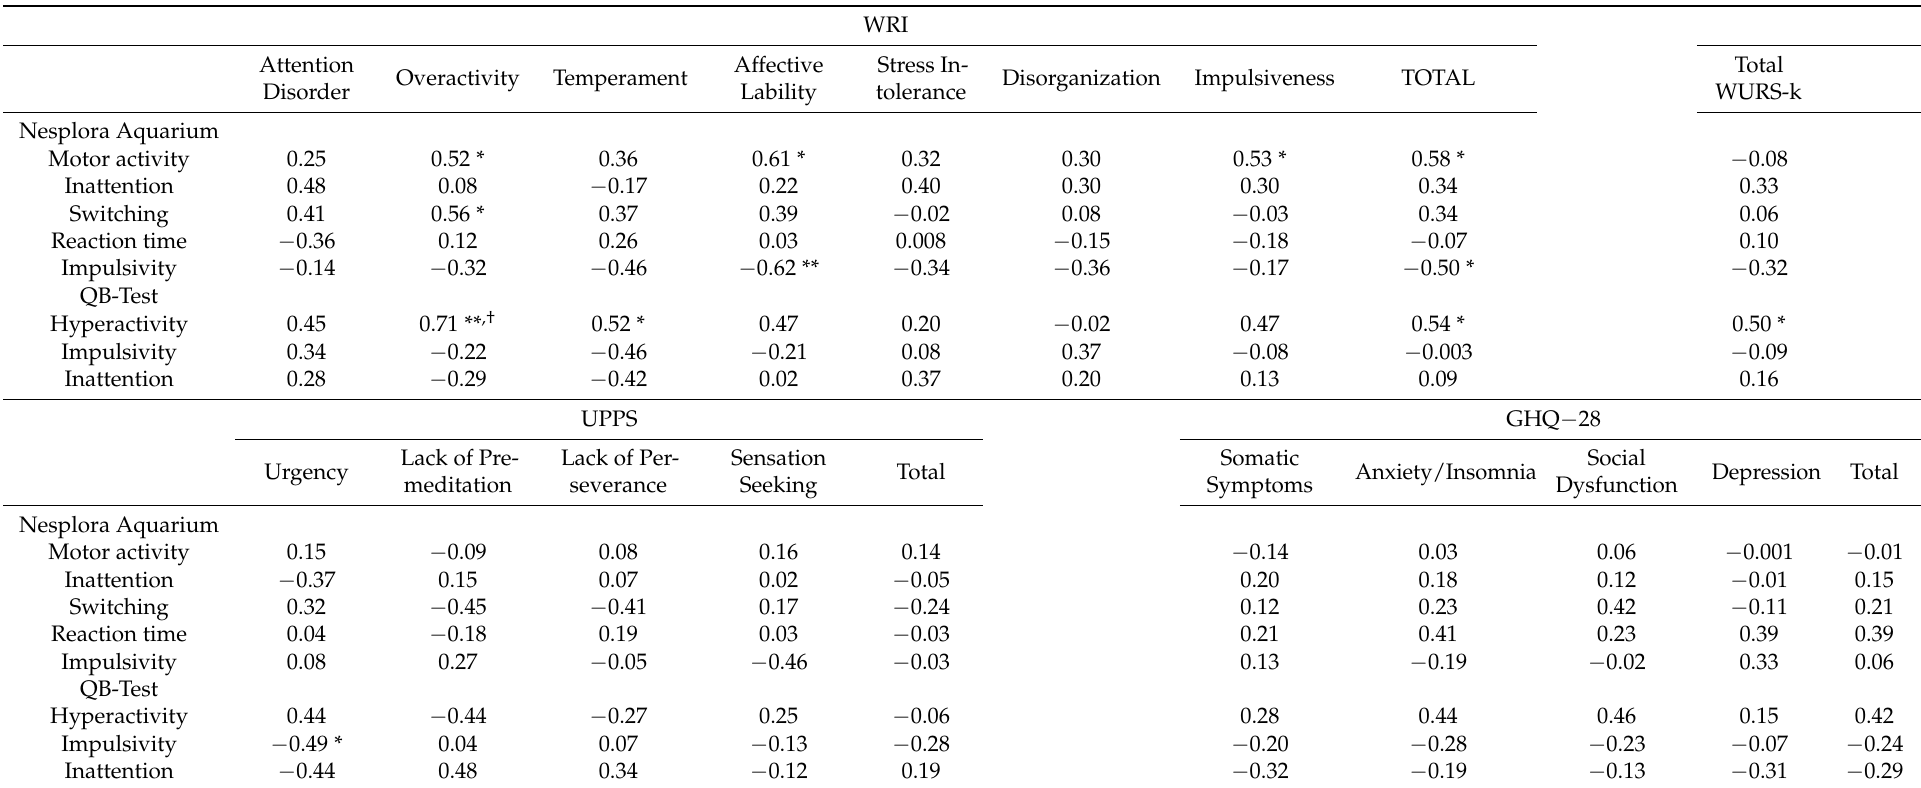
Table 5. Correlations between the principal components of Nesplora Aquarium and the Qb-Test with WRI, WURS-k, UPPS, and GHQ-28. Attention Overactivity Temperament Disorder